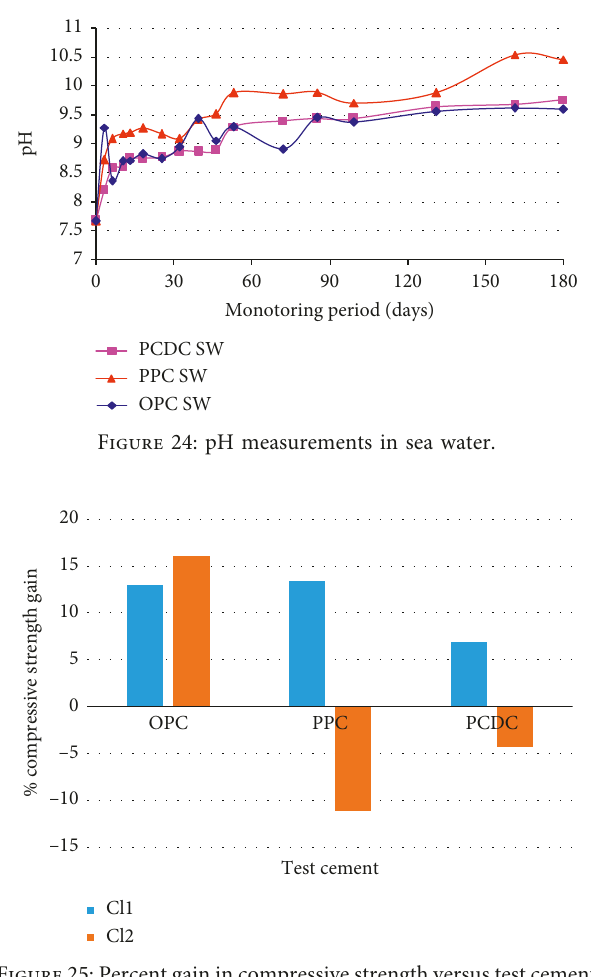
Figure 25: Percent gain in compressive strength versus test cement in chloride